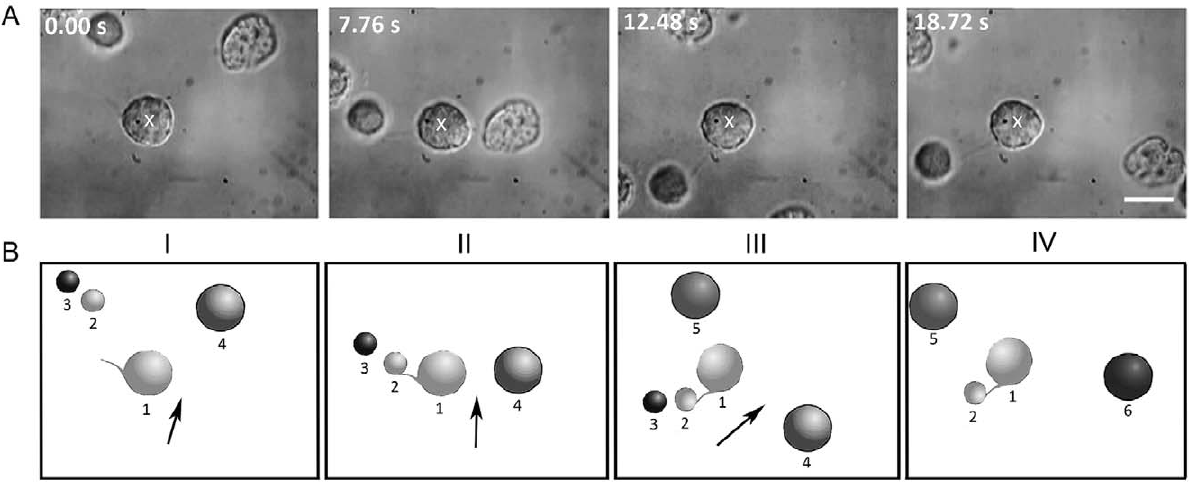
Figure 4. Time lapse images of cell adhesion dynamics. A) Real-time images and B) corresponding cartoon depictions showing filopodia- mediated adhesion. The white cross in image I denotes the position of the optically-trapped neural progenitor cell 1 that is made to move in the direction indicated by the arrow. Image II shows the filopodia of cell 1 coming into contact with cell 2. Upon moving cell 1 after a period of approximately 5 seconds (Image III), cell 2 also moves along, thereby indicating adhesion of cells 1 and 2, with a filopodial bridge between the two cells. Image IV (6 seconds later) shows that the cells remain adhered. The scale bar denotes 10 m m. See the real-time movie (Movie S1).